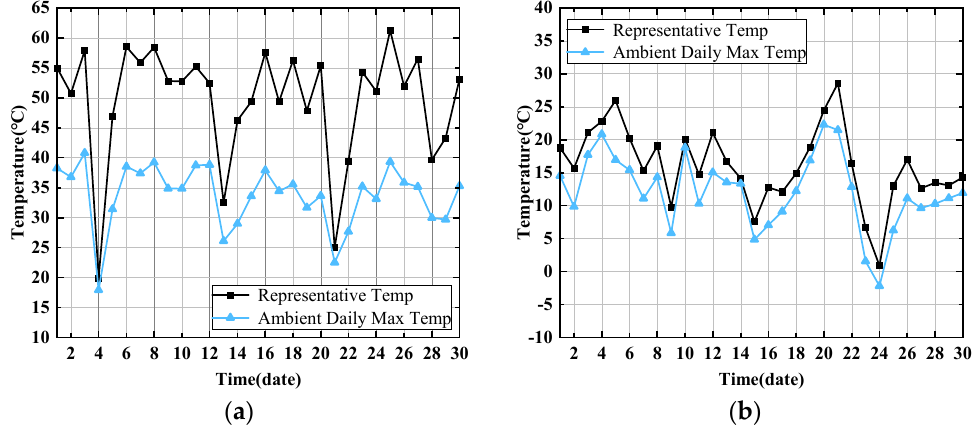
Figure 5. Monthly variation curves of measured. ( a ) summer; ( b ) winter.